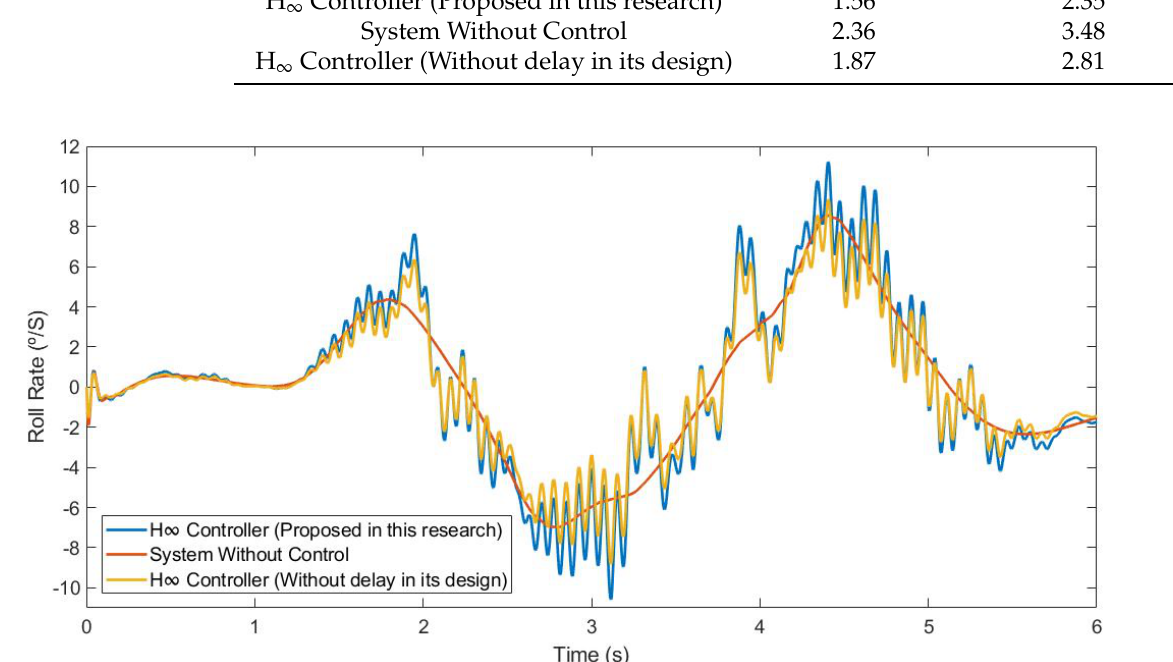
Figure 15. Roll rate for test 2: Double lane change at 100 km/h.